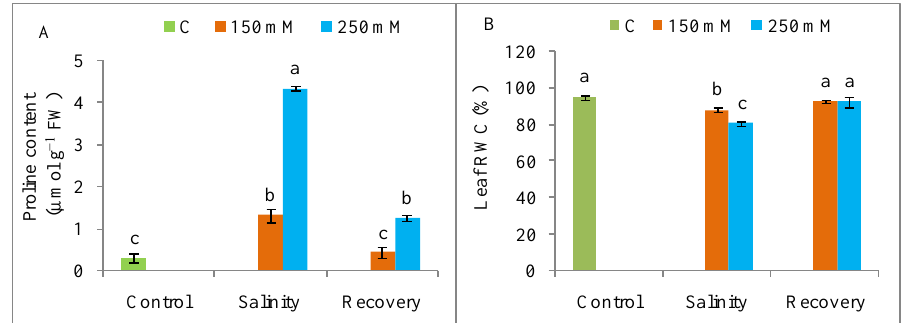
Figure 7. Osmotic status ( A ) proline (Pro) content, ( B ) leaf relative water content (RWC) in tomato plants under salinity (150 and 250 mM NaCl) and after a 48 h recovery period. Data means (±SD) were calculated from three replications. Statistically significant values are indicated by dissimilar letters (Fisher’s LSD test, P ≤ 0.05).